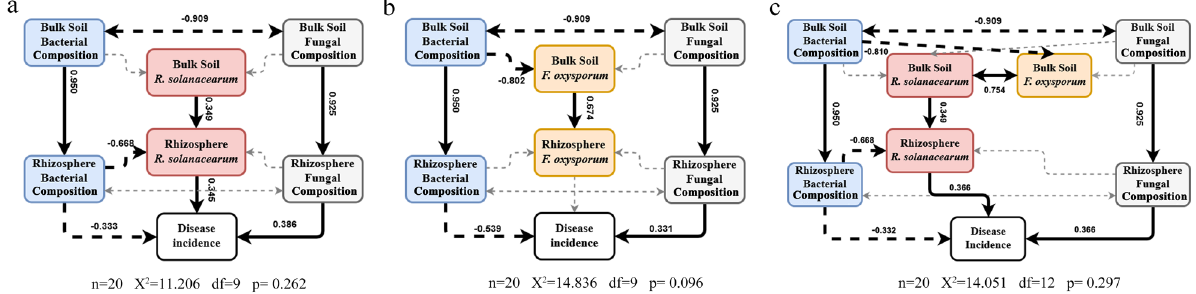
Fig. 5 Structure equation model (SEM) of the direct and indirect pathways in fl uencing disease incidence caused by two kinds of pathogens. a Only R. solanacearum was considered in SEM; b only F. oxysporum was considered in SEM; c both R. solanacearum and F. oxysporum were considered in SEM ( c ). Arrows represent the fl ow of causality. Solid and dotted lines represent statistically signi fi cant ( P ≤ 0.05) and non-signi fi cant relationships, respectively. The path coef fi cients associated with each arrow of signi fi cant relationships are